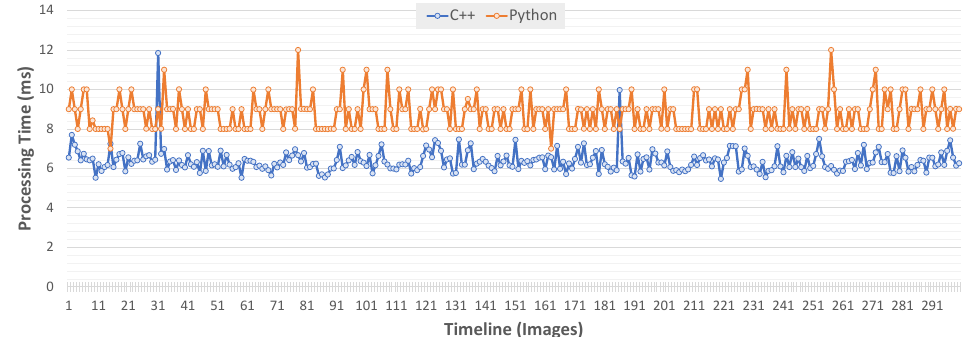
Figure 9. Processing times of the face detection algorithm in C++ and Python. For C++ DLL: average, 6.39 ms; minimum, 5.47 ms; maximum, 11.85 ms. For Python MQTT: average, 8.77 ms; minimum, 7 ms; maximum, 12